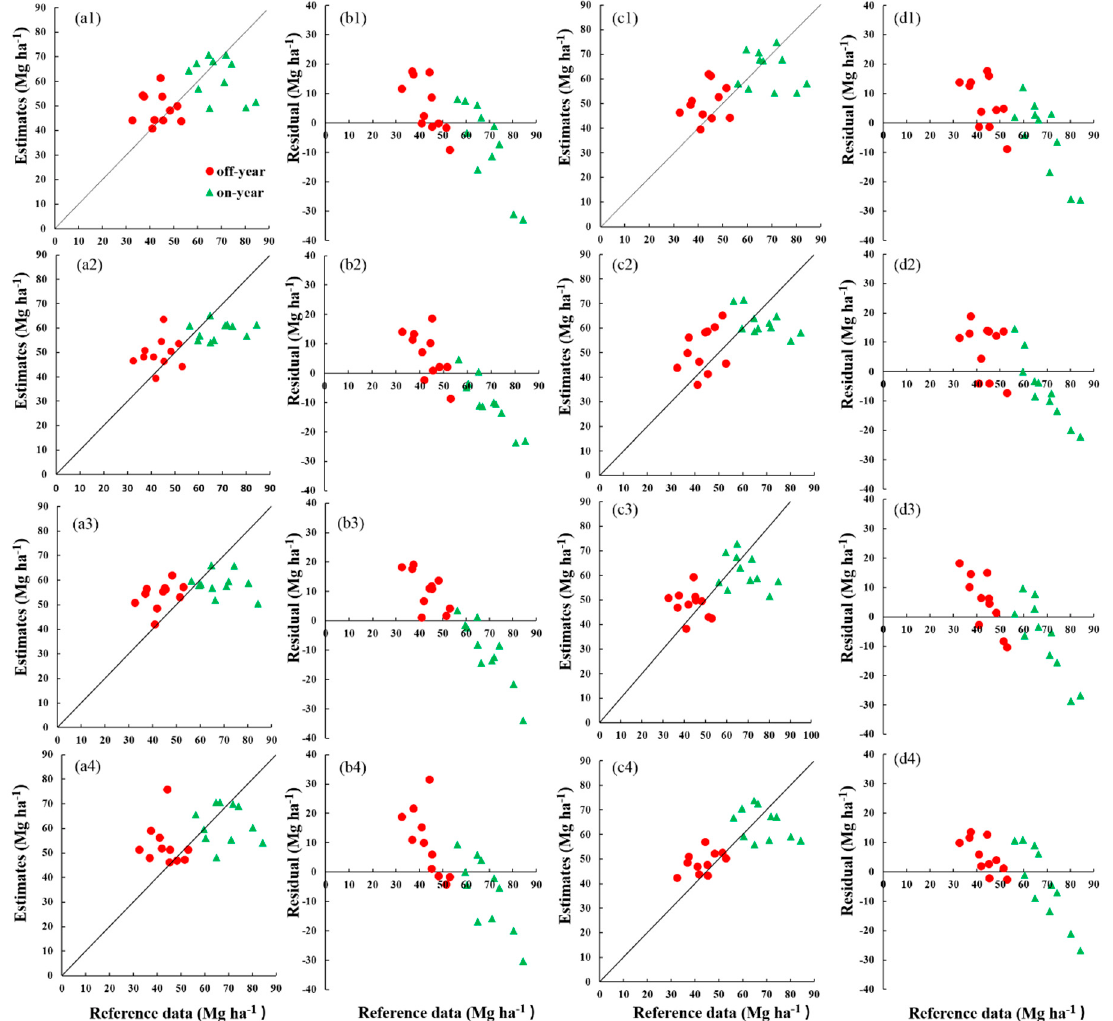
Figure 8. With non-stratification, ( a1 – a4 ) represent the relationships between biomass estimates and sample plots based on combined April and July images ( a1 ), individual April ( a2 ), May ( a3 ), and July ( a4 ), respectively, and ( b1 – b4) are corresponding residuals; with stratification, ( c1 – c4) represent the relationships between biomass estimates and sample plots based on combined two seasonal images ( c1 ), individual April ( c2 ), May ( c3 ) and July ( c4 ), respectively, and ( d1 – d4) are corresponding residuals.